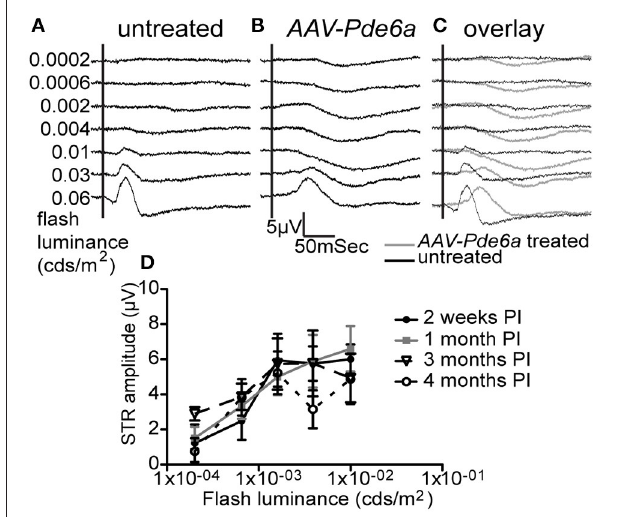
FIGURE 1 | Electroretinography. Five of 9 AAV-Pde6a treated eyes had a measureable scotopic threshold response (STR) on ERGs at light intensities below b-wave threshold (representative traces shown in A–C ). No untreated eye or AAV-GFP injected eye had the presence of an STR. The STR in those eyes with a detectable response increased in amplitude with increasing flash luminance, and the amplitude was sustained throughout the treatment period (D) .